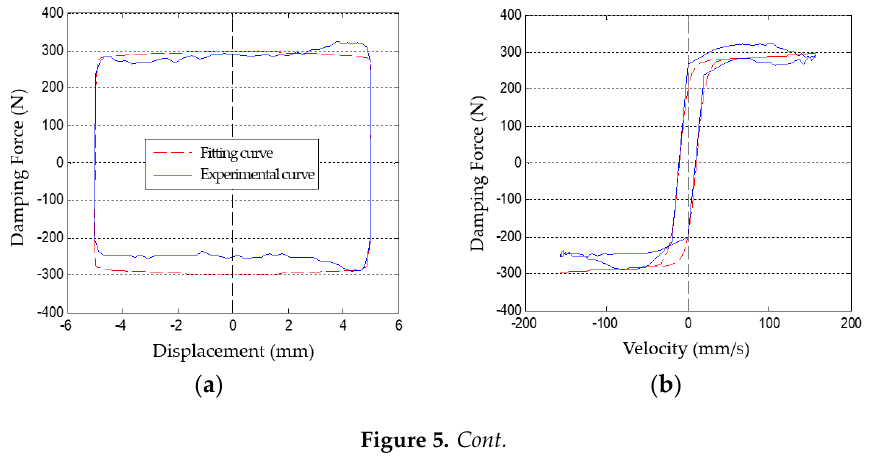
Figure 4. Genetic algorithm of parameter identification for the double-sigmoid model: ( a ) Flow chart of genetic algorithm; ( b ) Genetic algorithm toolbox